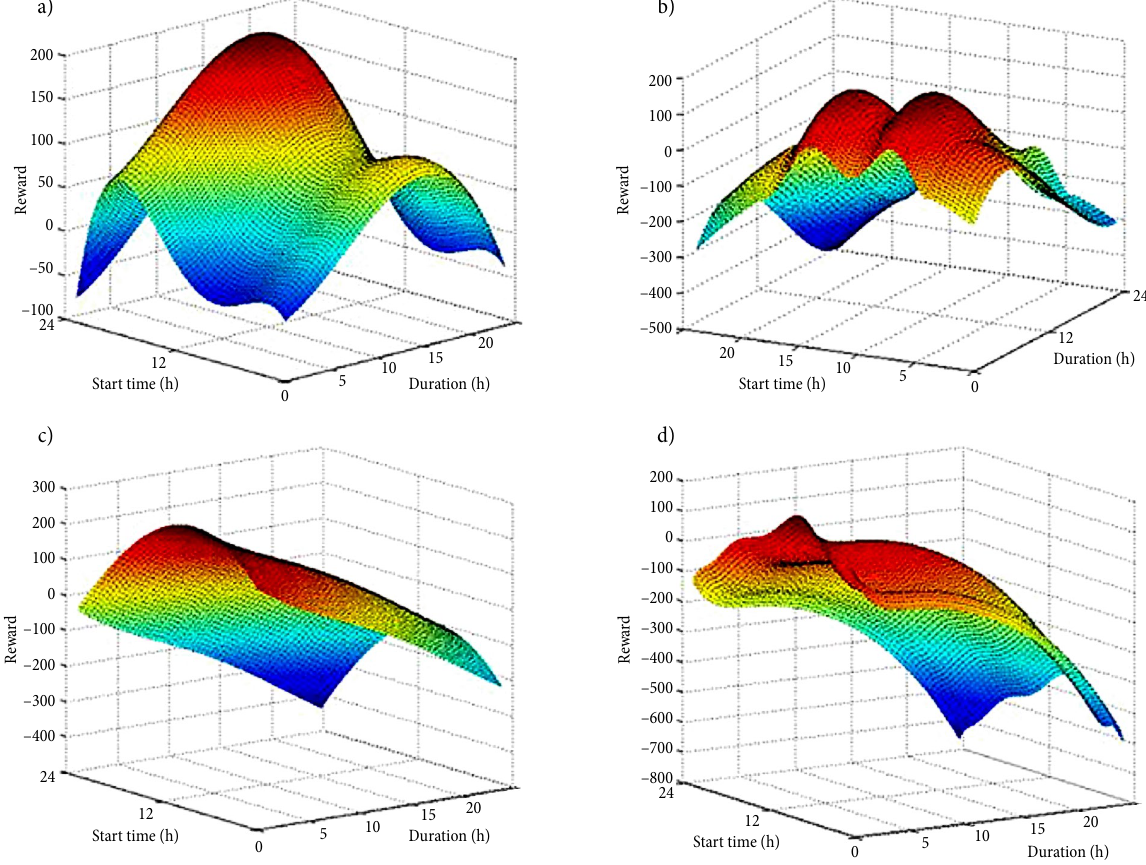
Fig. 2. Relationships between reward, activity start time and activity duration: a – home reward function; b – working reward function; c – leisure reward function; d – shopping reward